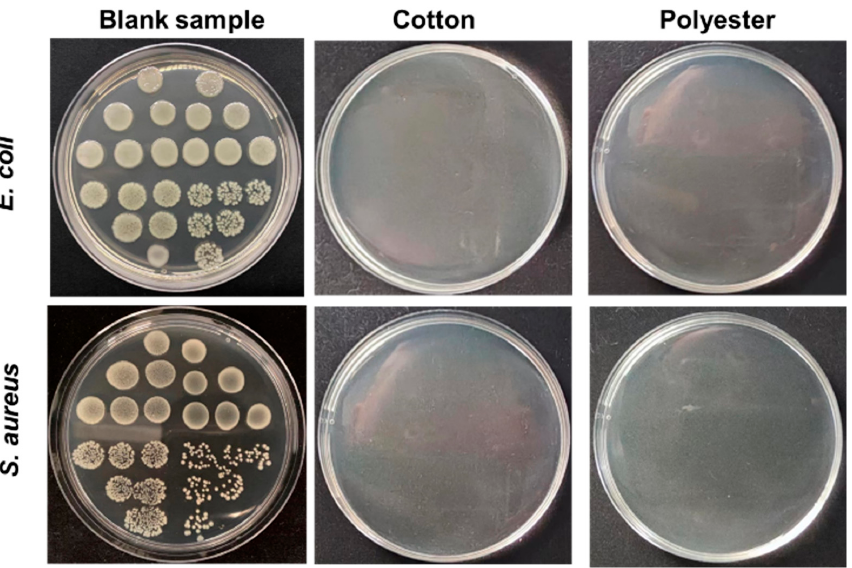
Figure 9. Plate bacterial colony count images of the bacteria eluent co-cultured with E. coli and S. aureus, which were collected from fabric surfaces. The silver contents of cotton and polyester fabrics in the experiments were ~500 mg/kg.